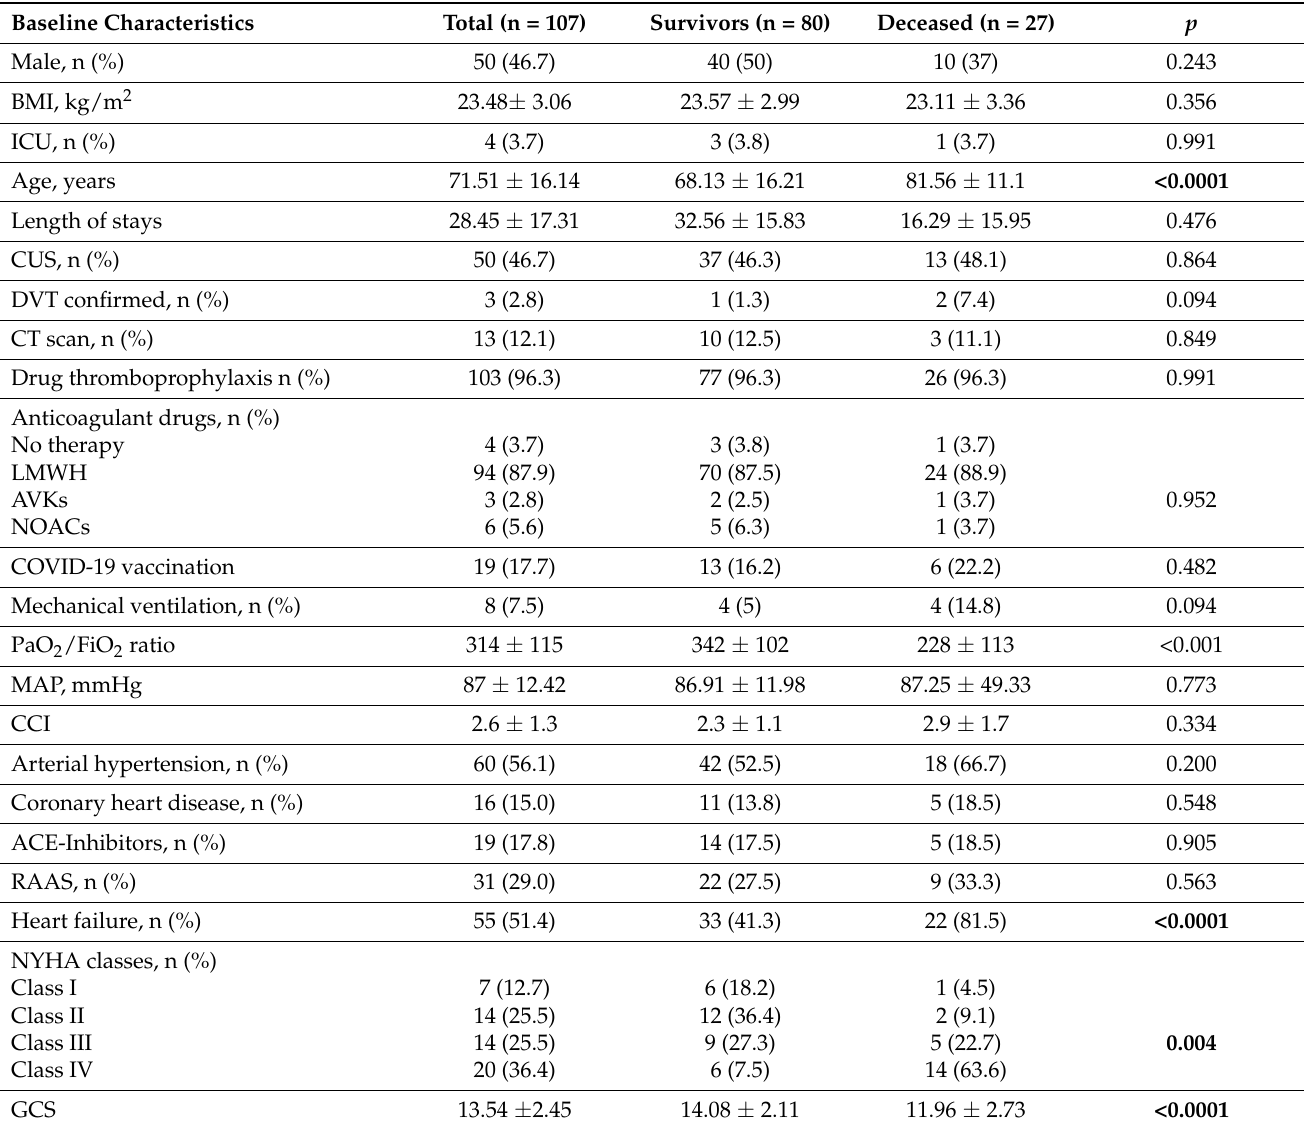
Table 1. Demographic and clinical characteristics of 107 COVID-19 patients included in the